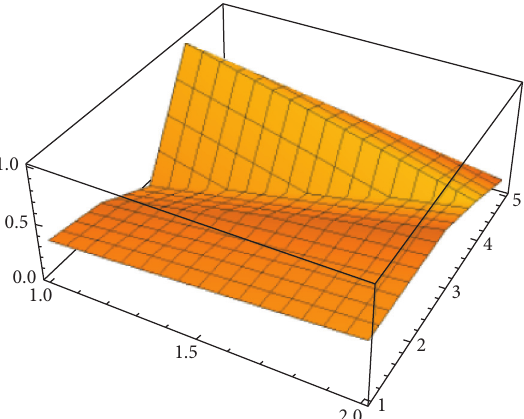
( η , ζ ) � η + ζ . Clearly, the fixed b